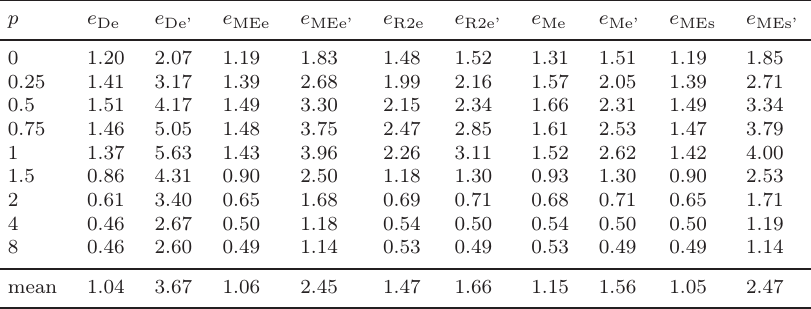
Table 3. Means of error ratios for extrapolated approximations, n = 2 .